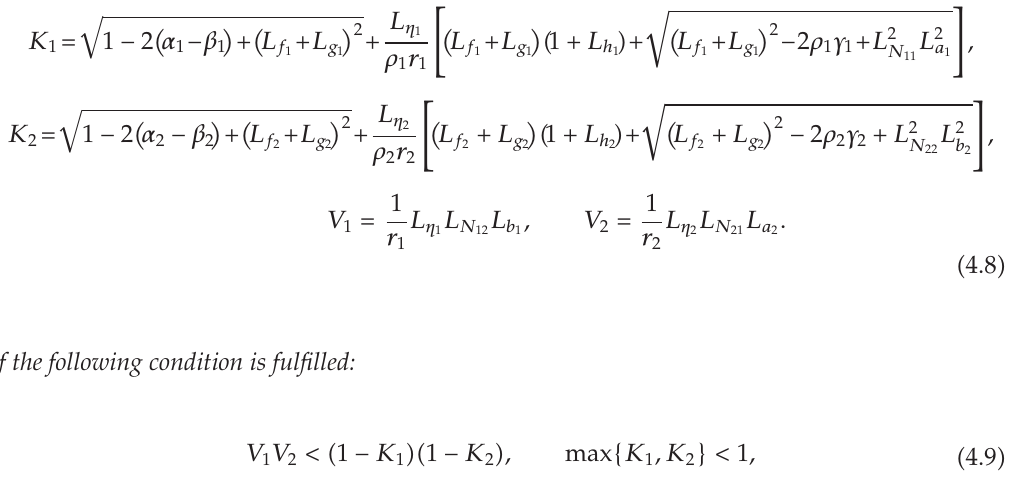
x n (cid:7) 1 (cid:6) (cid:4) 1 − σ n (cid:5) x